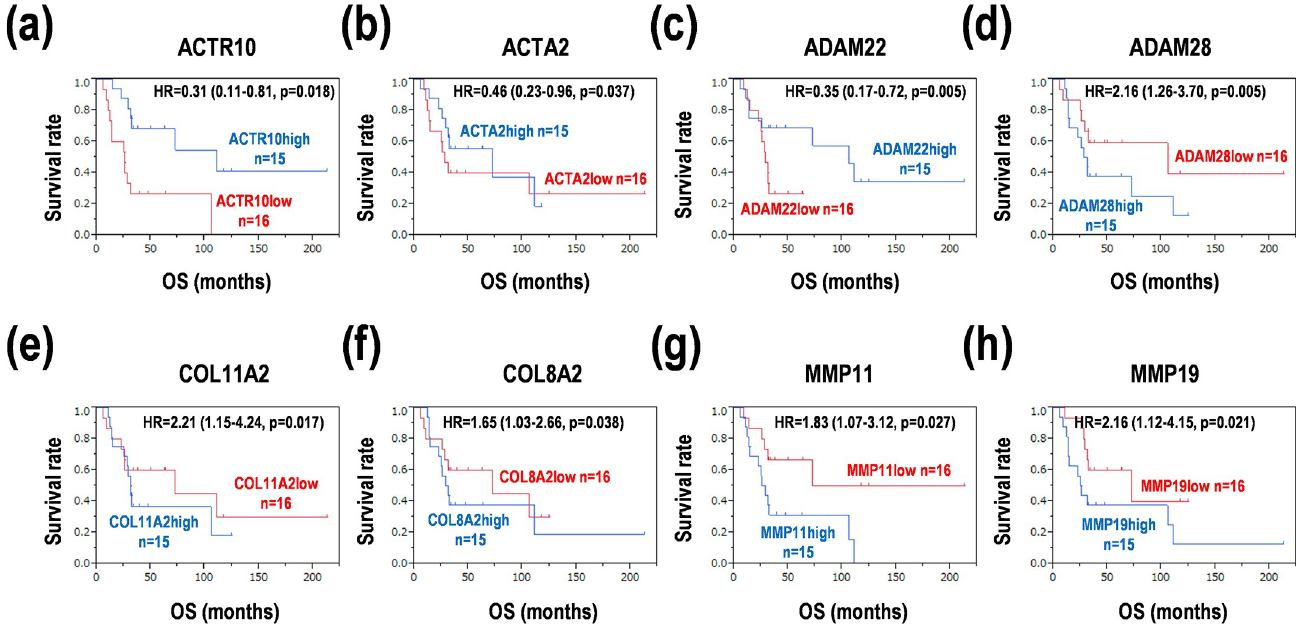
Fig 1. Survival distributions of the subgroups with the expression of the genes in PCNSL. ( a ) ACTR10 . ( b ) ACTA2 . ( c ) ADAM22 . ( d ) ADAM28 . ( e ) COL11A2 . ( f ) COL8A2 . ( g ) MMP11 . ( h ) MMP19 . HR; hazard ratio, OS; overall survival. Log-rank test; p <